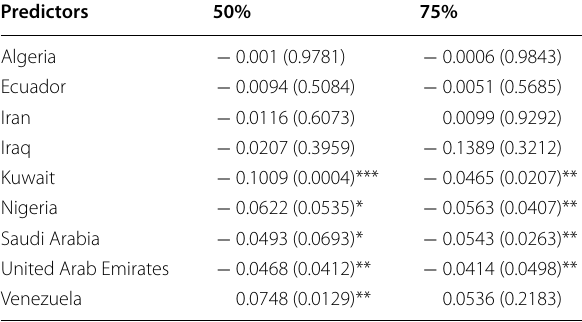
The probabilities associated with the first-order autoregressive coefficients are represented by values in parenthesis. ***, ** and * denote 1%, 5%, and 10% levels of significance, respectively